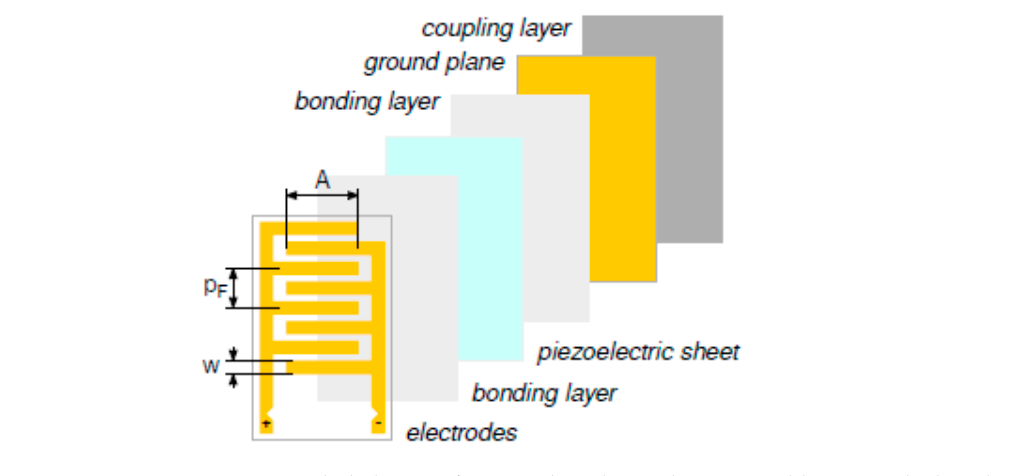
Figure 5. Exploded view of an interdigital transducer assembly. “A” is the length of the electrodes (fingers), “p F ” is the finger pitch and “w” is the finger width.